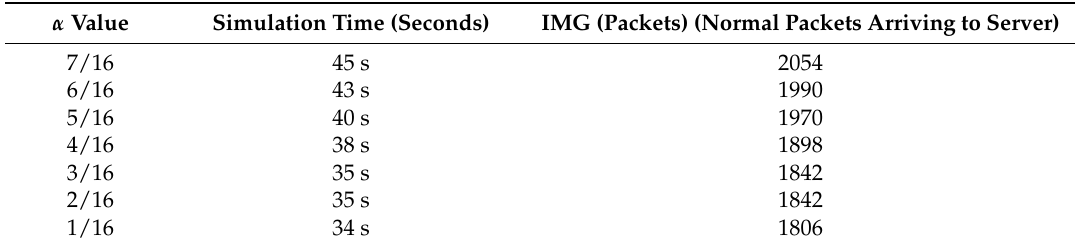
Table 4. Packets and time statistics for the experiment in different α